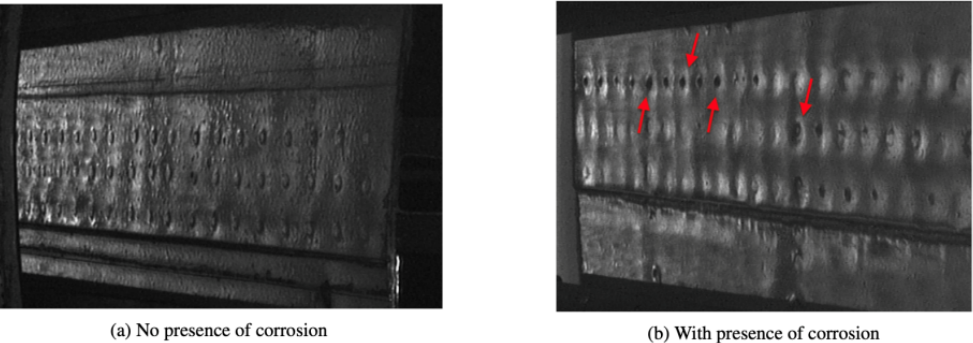
Figure 3. Two samples taken with the DAIS 250c device of a simple shear lap joint. ( a ) An image with no corrosion; and ( b ) the corrosion pillowing affecting rivets in red